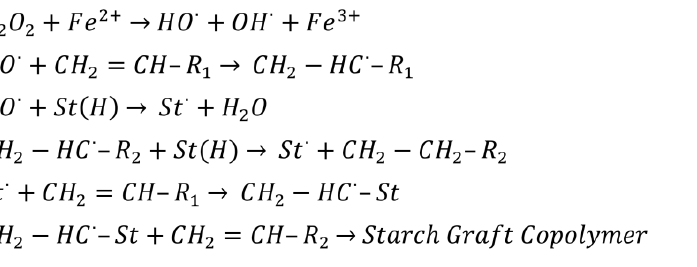
Figure 15. Fe 2+ /H 2 O 2 initiation of vinyl monomer or starch. Adapted from Figure 15. Fe 2+ / H 2 O 2 initiation of vinyl monomer or starch. Adapted from [15].